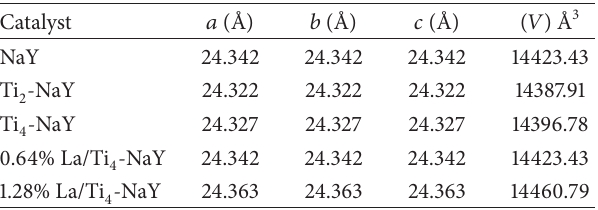
Table 3: Unit cell parameters (˚A) and (𝑉) crystal volume (˚A 3 ) of different